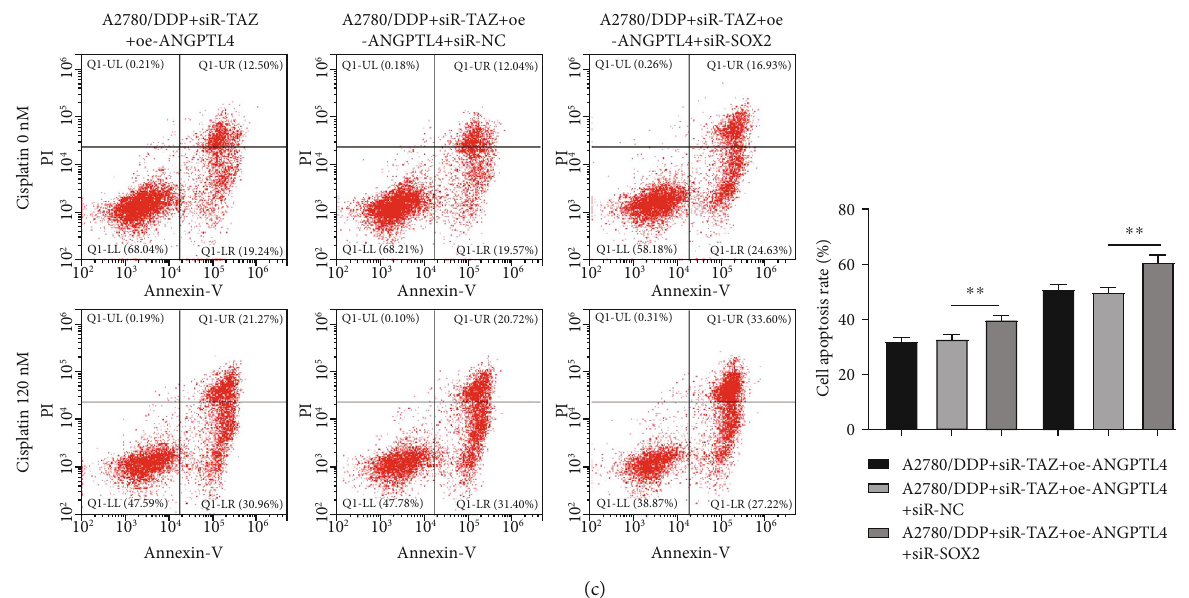
Figure 5: ANGPTL4 regulated the DDP sensitivity of drug-resistant EOC cells through SOX2. The drug-resistant EOC cells were transfected with siR-SOX2 based on TAZ knockdown and ANGPTL4 overexpression. (a) Protein expression of SOX2 was detected by WB. (b) Drug sensitivity was measured by CCK-8. (c) Apoptosis rate was determined by fl ow cytometry. Cell experiment was repeated three times. Data are presented as mean ± SD and one-way ANOVA was used for comparisons among groups. Tukey ’ s multiple comparisons test was adopted for the post hoc test. ∗ P < 0 : 05 , ∗∗ P < 0 : 01